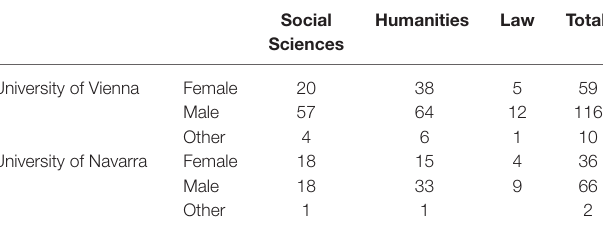
TABLE 1 | Senior Researchers.